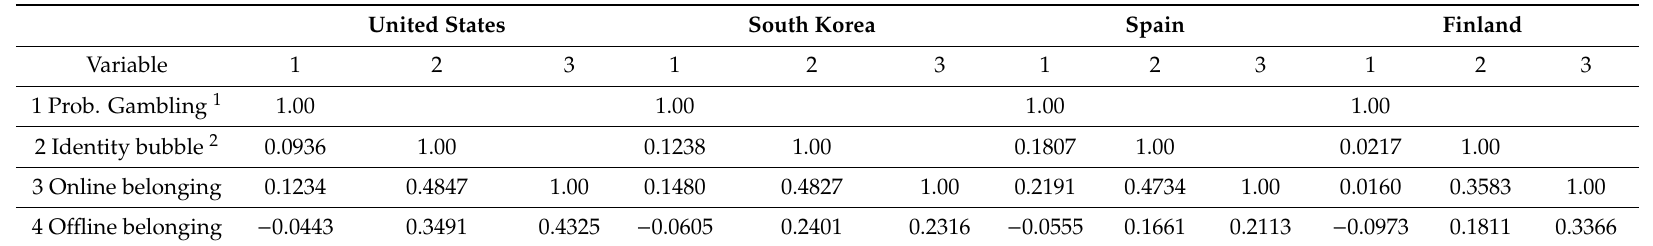
Table 2. Correlations of the Main Variables